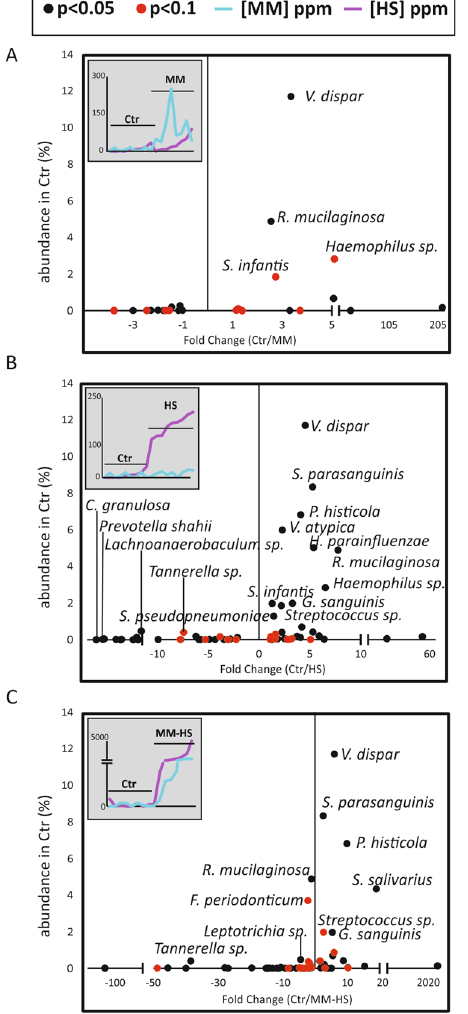
Fig. 3 Microbial differences between control and halitosis metatranscriptomes. The graph shows bacterial species with signi fi cant differences ( p < 0.05; DESeq2 test) or a statistical trend (0.05 < p < 0.1) between the control group and MM ( A ), HS ( B ) or MM-HS ( C ) groups. The Y-axis represents the abundance of each bacterial species in the control group, whereas the X-axis represents the difference in abundance as fold-change (Control/halitosis). The names of those species with >1% abundance are indicated. The concentrations of VSCs in the samples from the two groups compared are also shown, for reference.